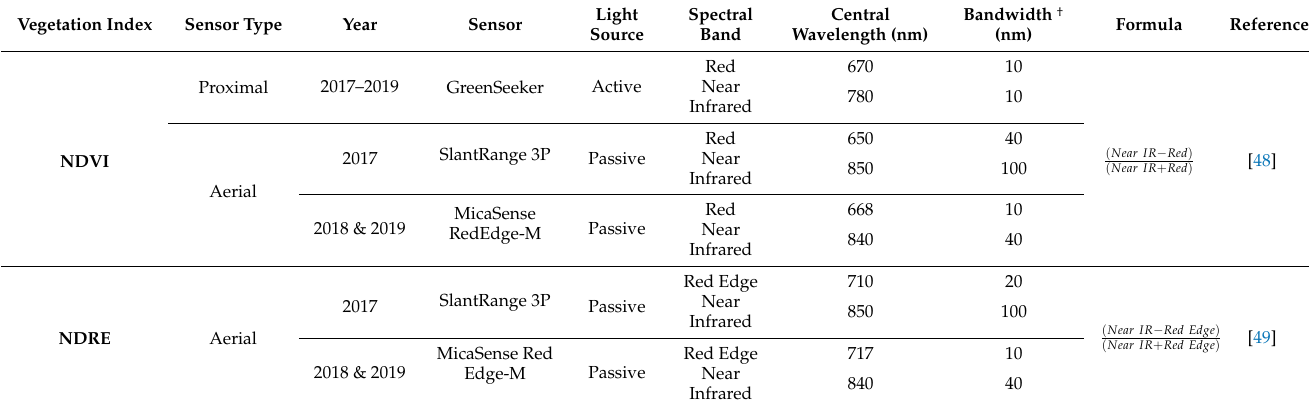
Table 2. Summary of the proximal and aerial sensors used to measure the Normalized Difference Vegetative Index (NDVI) and the Normalized Difference Red Edge (NDRE) at the panicle initiation (PI) rice growth